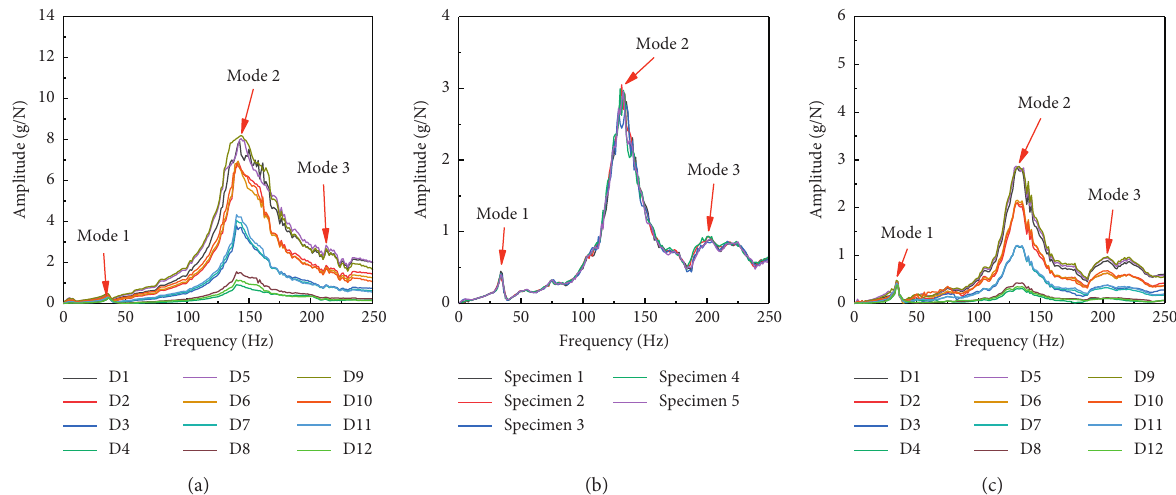
Figure 17: The frequency response curves (FRCs) of baseplate and composite structure with EMWM core. (a) The FRCs for baseplate at different measure points. (b) The FRCs for composite structure with different core at measure point D1. (c) The FRCs for composite structure at different measure points under room temperature.